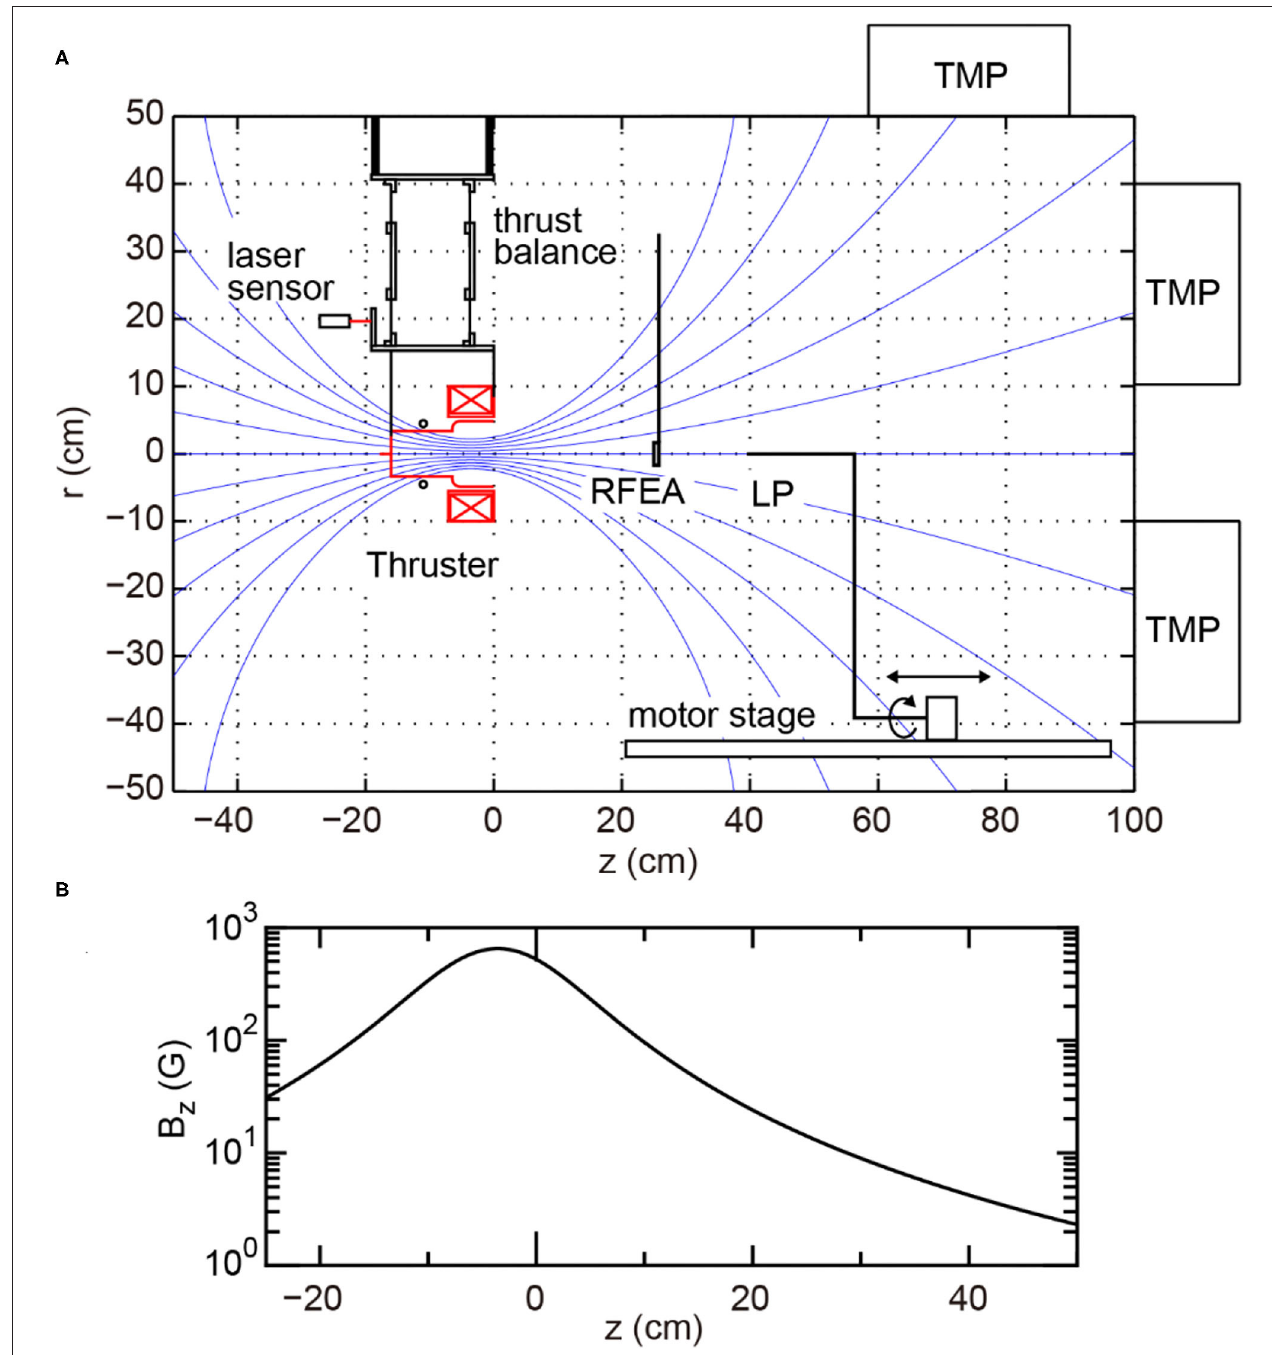
FIGURE 1 | (A) Schematic diagram of the experimental setup together with the calculated magnetic field lines (blue solid lines). (B) Calculated magnetic field strength on the z axis. is also found to approach the target value of 500 W during the target value of the net power are set at ∼ 39.1 MHz, the pulse. 100 msec, and 500 W, respectively. It is found that the rf By taking data of 1,000 shots, the statistical analyses for the frequency automatically changes from ∼ 39.1 to ∼ 38.7 MHz tuning time ( t tune ), the rf powers ( P f , P r , P net ), and the square within the initial 7 msec; the value of Γ 2 is significantly r of the reflection coefficient ( Γ 2 ) are performed, where t tune reduced from unity to 0.03, corresponding to the power r is defined as the time spent for reducing the value of Γ 2 reflection of about 3%, at t ∼ 7 msec. The net power P net r